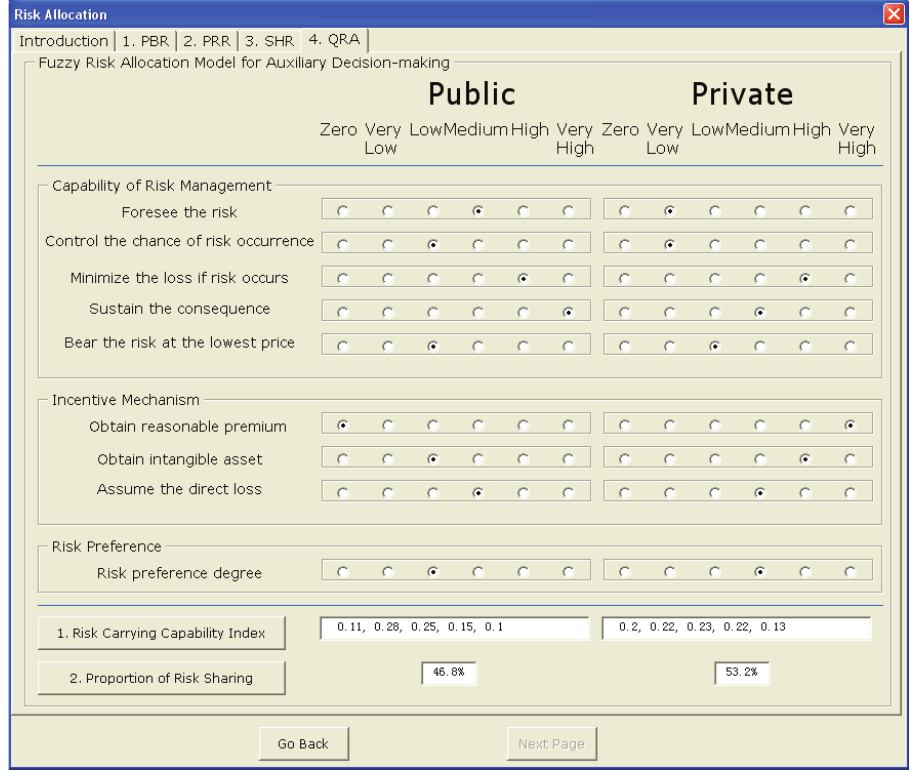
figure 7. Interface of a computerized risk allocation